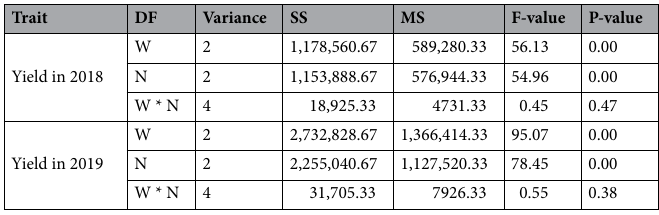
Table 3. Variance analysis of traits on the yield of Isatis indigotica .